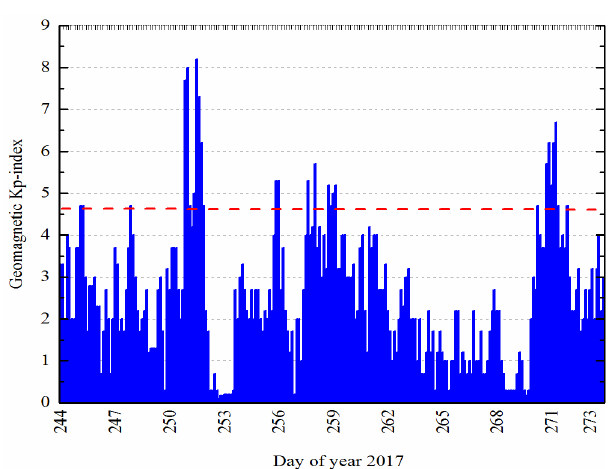
Figure 3. Geomagnetic Kp-index in Sep 2017. According to Table 1, when the Kp-index is greater than 4.67, the conditions can be considered a magnetic storm. Therefore, the periods above the red dotted line mark magnetic storm occurrences.